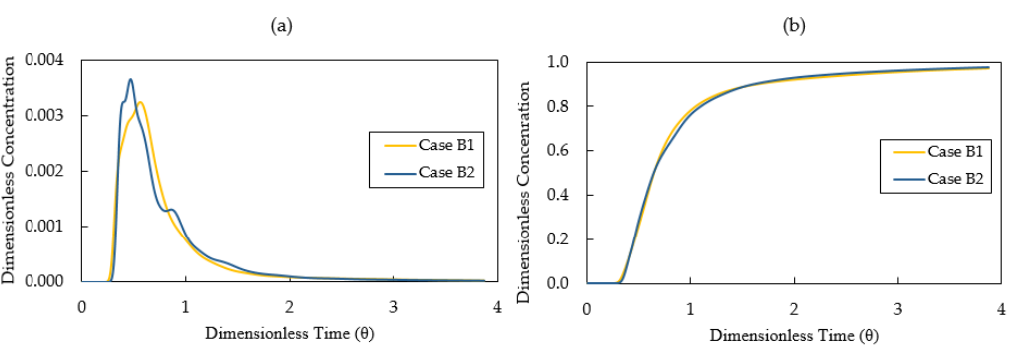
Figure 14. ( a ) E-curve and ( b ) F-curve for Case B1—without thermal buoyancy and Case B2—with thermal buoyancy. Table 5. RTD analysis for Case B1 and Case B2.